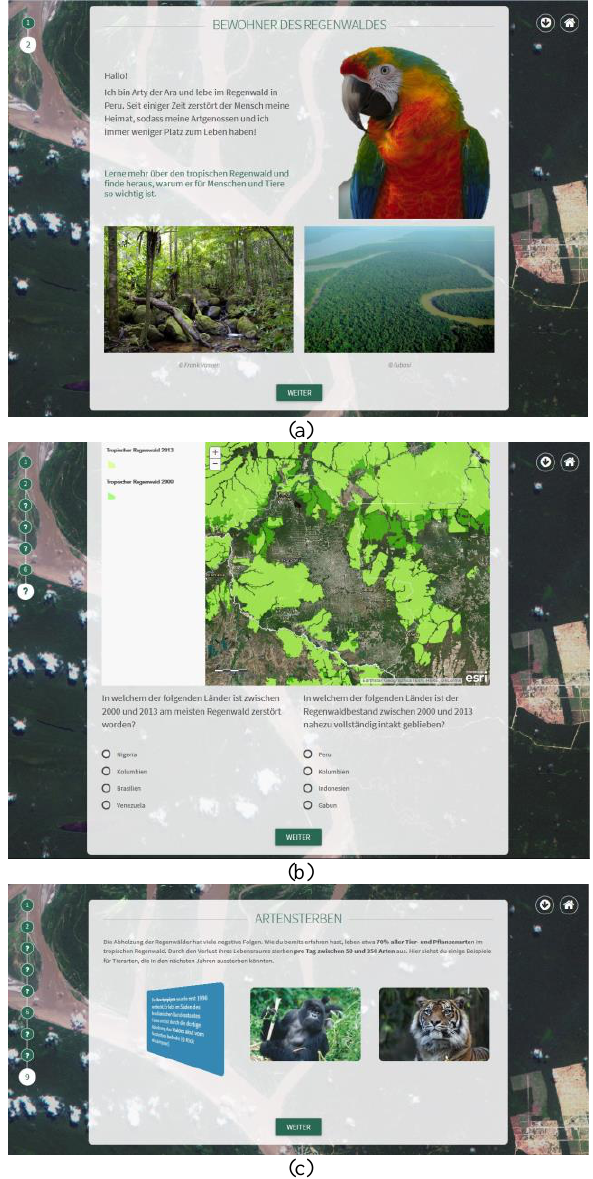
Figure 2. Screenshots showing some exemplary knowledge units of the learning module “Deforestation of the rainforest in